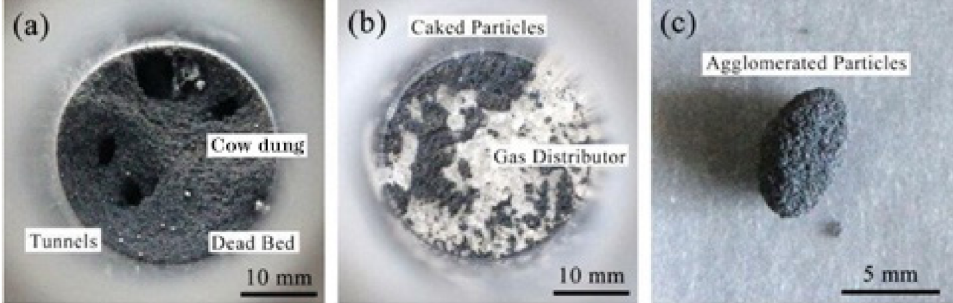
Figure 9. Bonding behavior diagram.